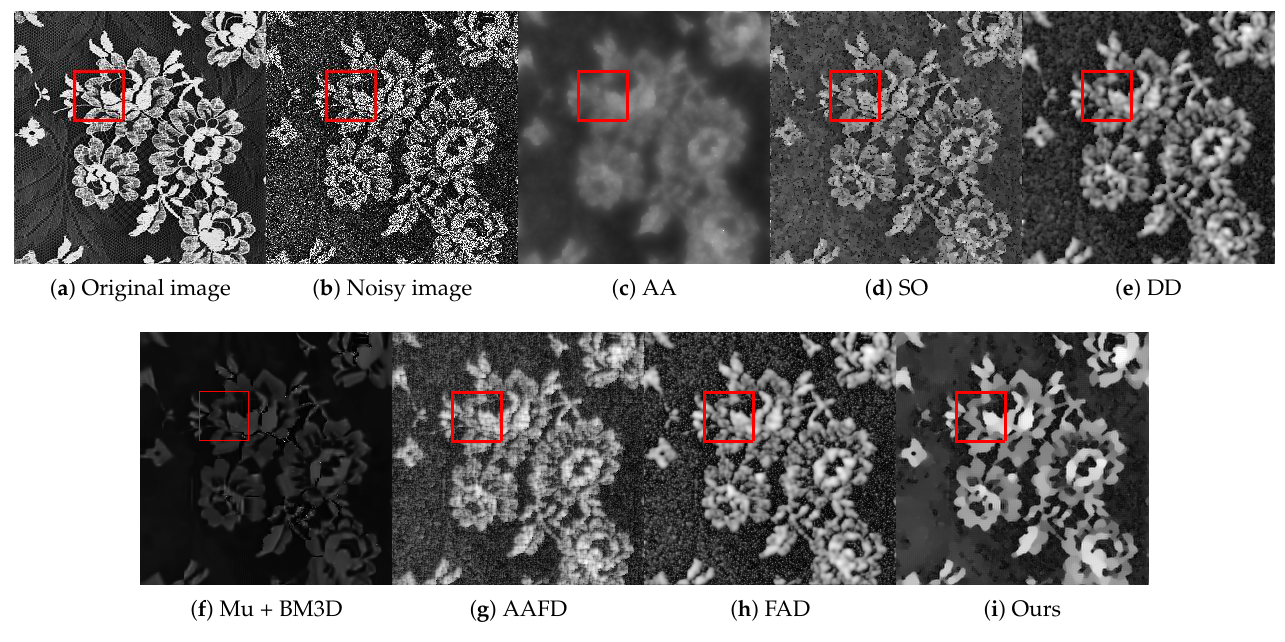
Figure 8. ( b ) Noisy: L = 1. ( c – i ) Denoised results.